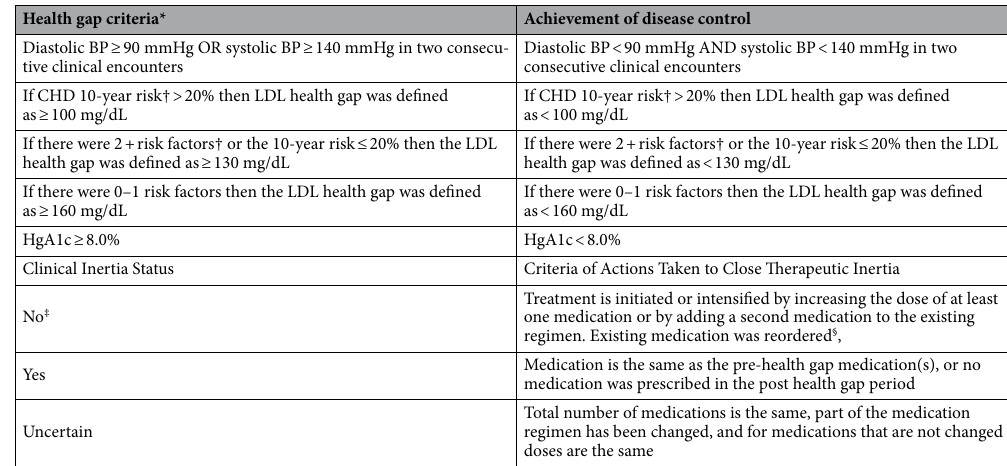
Table 1. Operational criteria for defining health gaps, health gap closure and clinical inertia. *—Criteria are consistent with the American College of Cardiology (ACC)/American Heart Association (AHA) guidelines. †—Factors used to estimate coronary heart disease (CHD) risk: age, total cholesterol, smoking status, HDL, systolic BP, and antihypertensive treatment. The formula can be found in ATP III guidelines. ‡—Assumes that the physician discussed adherence with the patient, but the patient may have also acted on their own to improve treatment adherence. §,—Assumes that the physician recognized the patient self-care gap and acted to close the care gap with a new prescription order with or without contacting the patient.